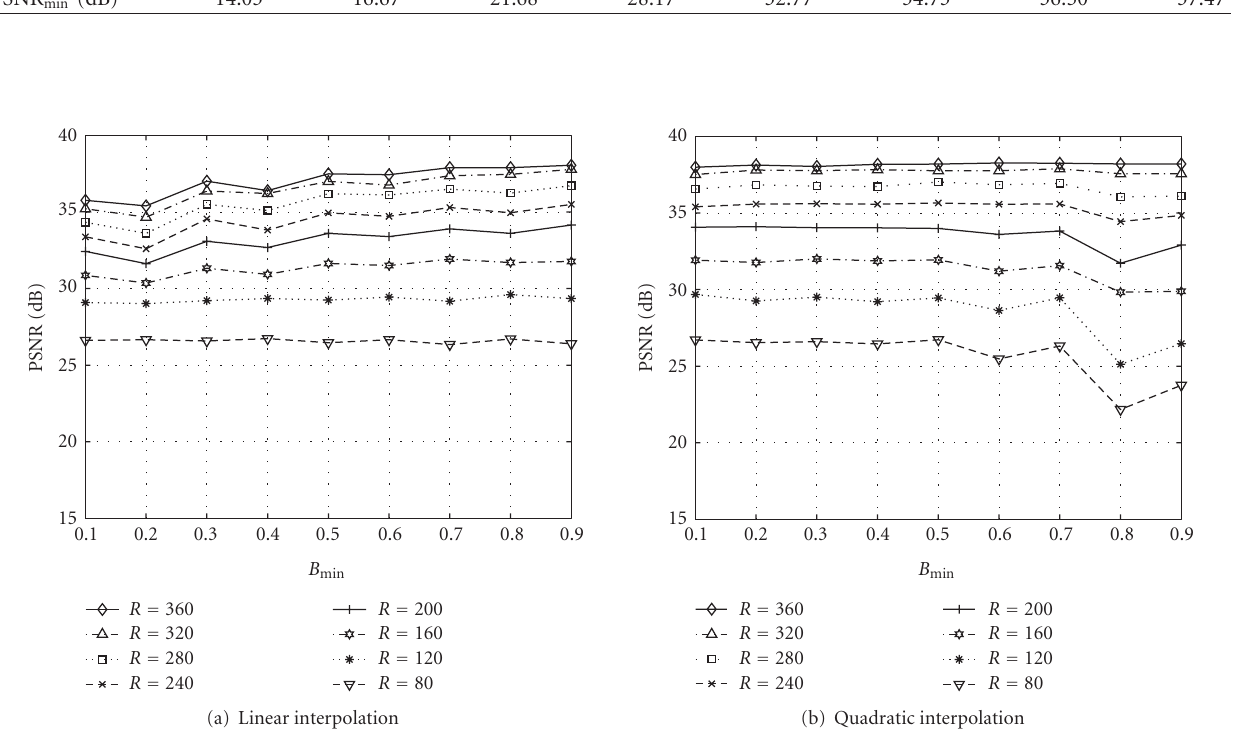
Figure 7: Performance of DM-based frame dropping, R represents the outlink rate in